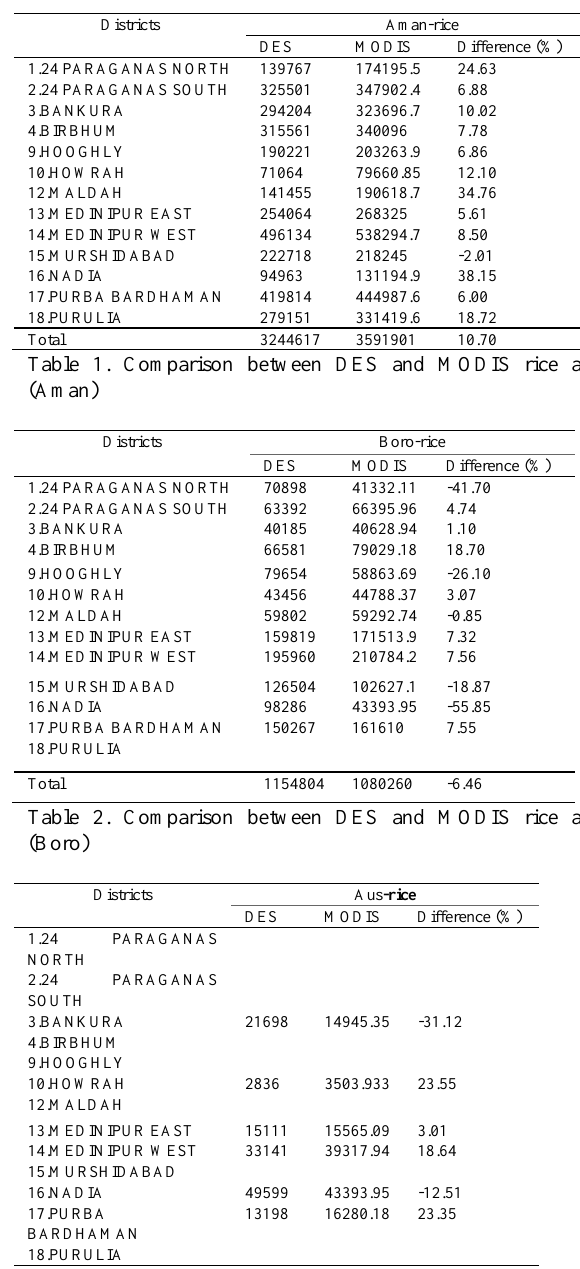
Table 3. Comparison between DES and MODIS rice area